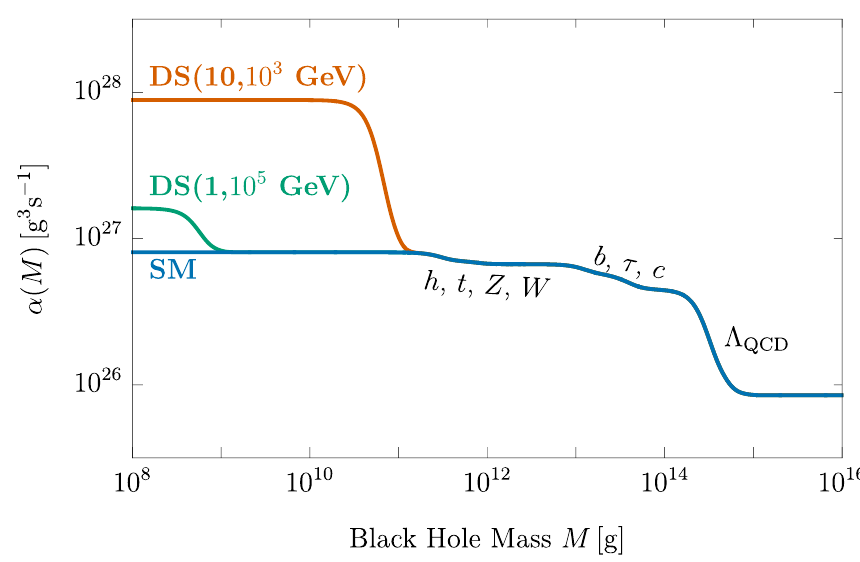
Figure 2: The function α ( M ) , which accounts for all directly emitted particle species, for the SM and two dark sector models (see text for details). The SM particle labels show the particles responsible for the thresholds. Light quarks and gluons are only radiated above Λ QCD